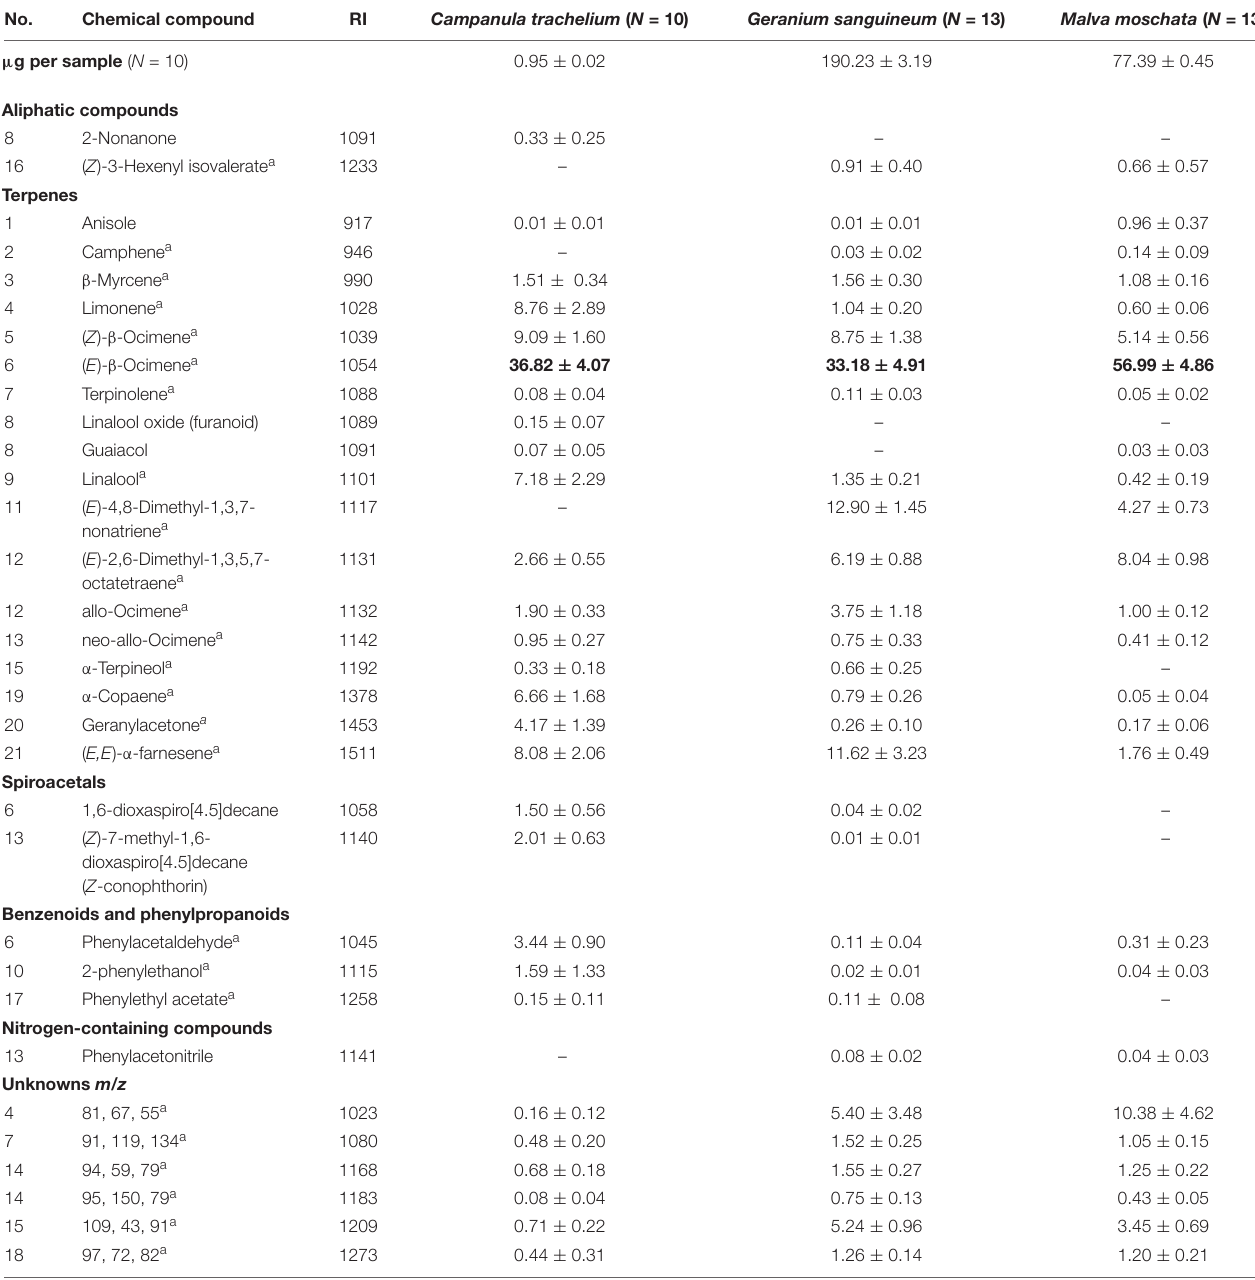
TABLE 1 | Absolute (first line) and relative amounts (mean ± standard error) of GC-EAD active compounds in the headspace samples of inflorescences from C. trachelium , G. sanguineum , and M. moschata . No. Chemical